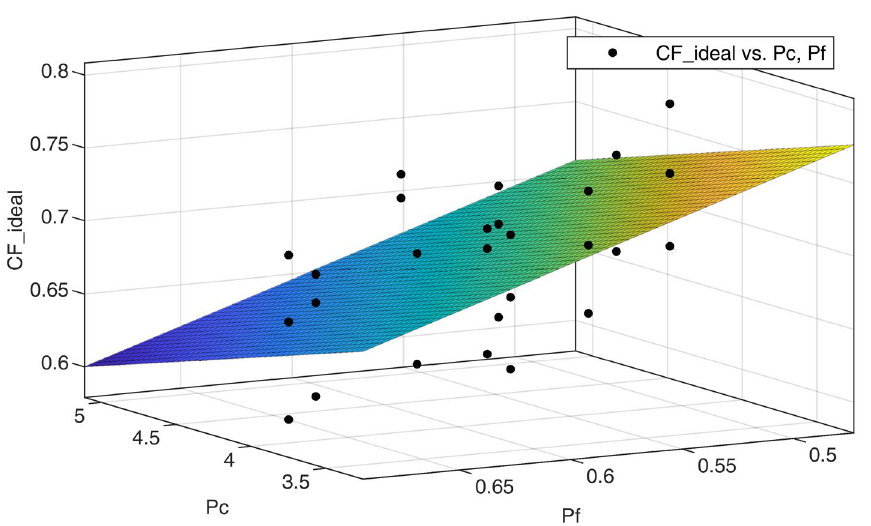
Figure 5. 3D regression of the final selected parameters displaced diameter as P C and relative flank area as P F on the ideal correction